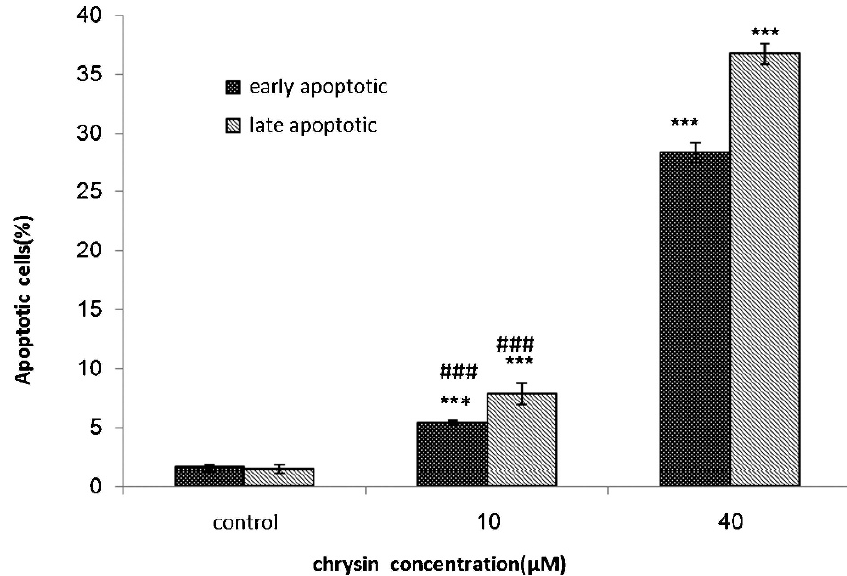
Figure 5 - Assessment of apoptosis by Annexin V/PI on human prostate cancer cells (PC-3). Percentage of cell death based on the assessment of apoptosis by Annexin V/PI. *** indicates p , 0.001 compared to control and ### indicates p , 0.001 compared to the